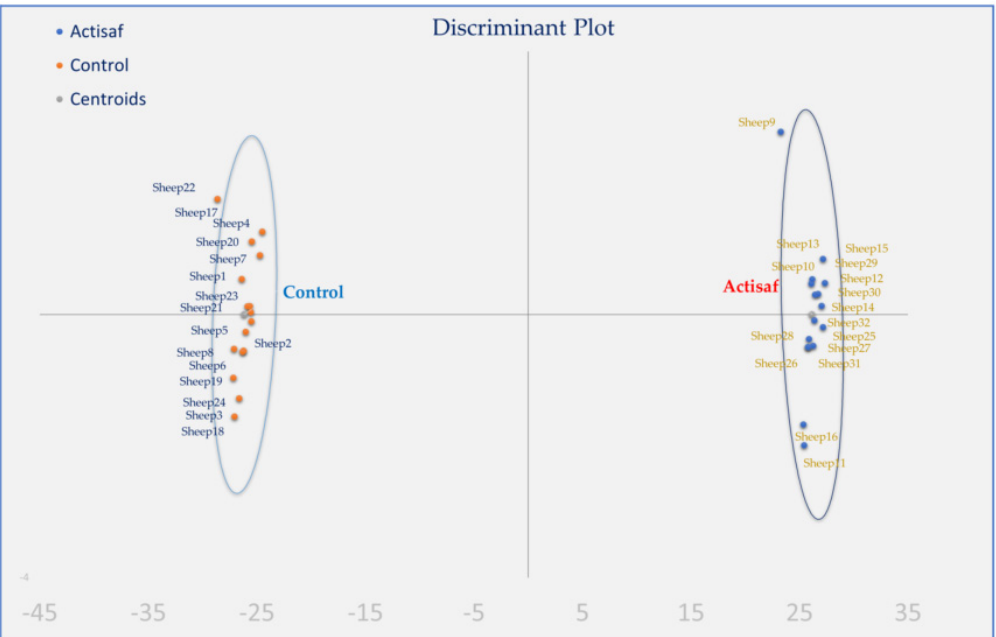
Figure 5. Discriminant plots separating the Control and ActiSaf fed ewes according to their fatty acid grouped values, immune gene expression in both monocytes and neutrophils, and antioxidant indices in blood and milk.